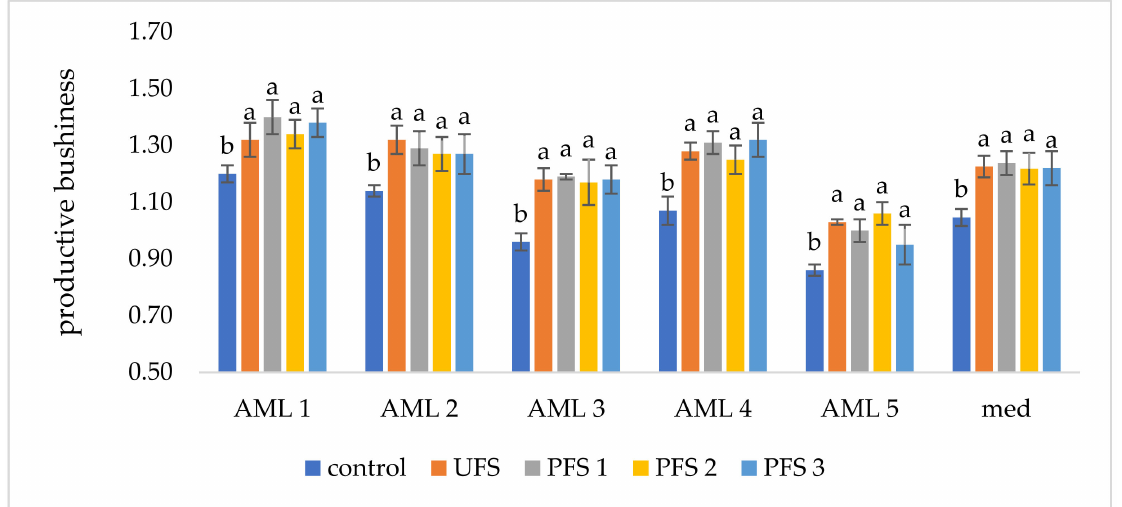
Figure 9. Productive bushiness of oat plants in the experiment. The different letters represent statistically significant ( p ≤ 0.05) differences between the tested options of fertilizer application. Error bars show the standard deviation of the mean value ( n = 15). AML 1 is the eluvial agricultural microlandscape, AML 2 is